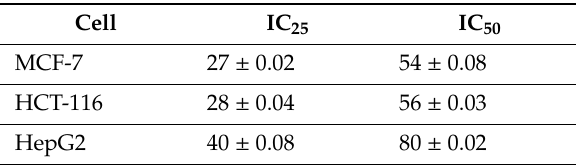
Table 2. IC 25 and IC 50 values of Nostoc -mediated synthesized silver nanoparticles (N-SNPs) ( µ g / mL) used in all experiments against MCF-7, HCT-116, and HepG2